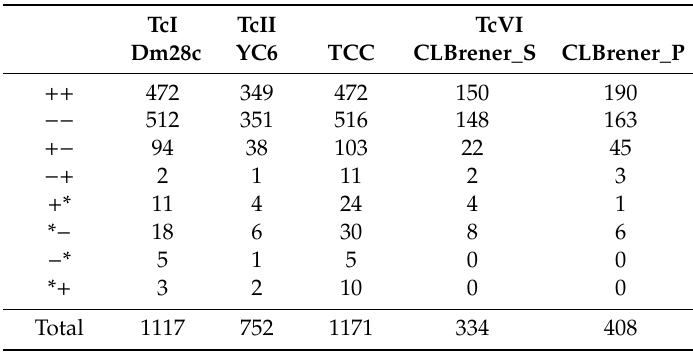
Table 3. Number of repeats found in the intergenic region of each T. cruzi strain. The + symbol indicates gene transcription from the sense strand, and the − symbol indicates gene transcription from the anti-sense strand. The left symbol represents the gene at the left side of the repeat, and the right symbol represents the gene at the right side of the repeat. TcI